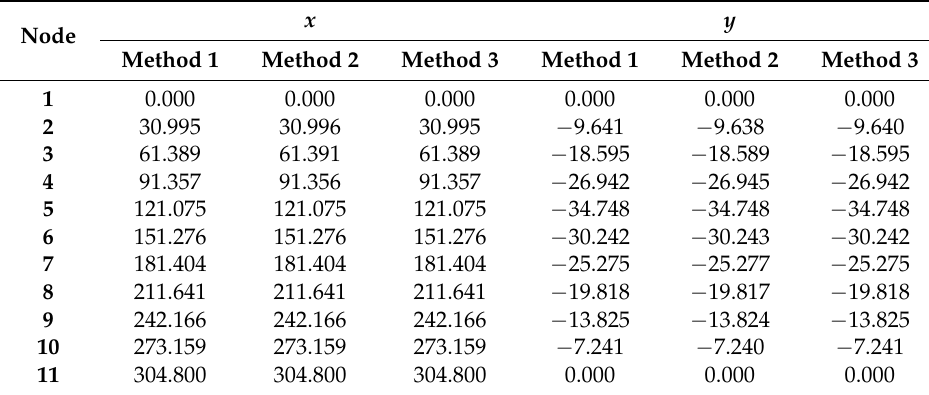
Table 6. Node coordinates of cable segments under applied load (unit: m).